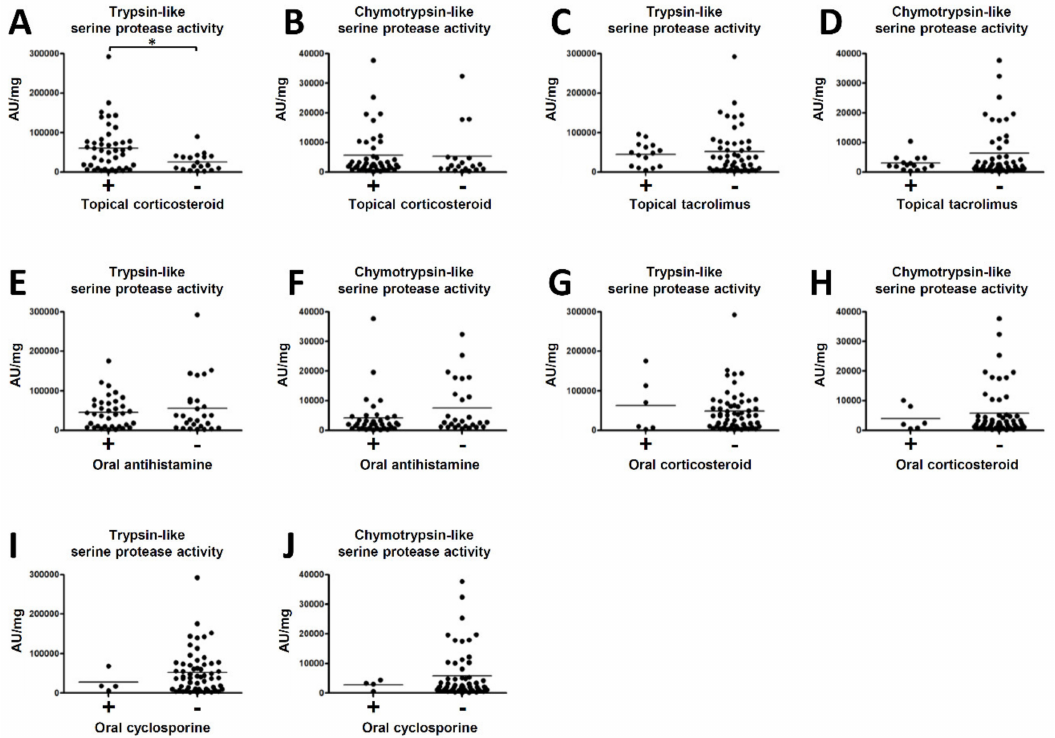
Figure 2. The association between serine protease activity in the SC in lesions of AD patients and medical treatments. Trypsin- or chymotrypsin-like serine protease activity in lesions were compared with and without topical corticosteroid ( A , B ), topical tacrolimus ( C , D ), oral antihistamine ( E , F ), oral corticosteroid ( G , H ) and oral cyclosporine therapies ( I , J ). * p <